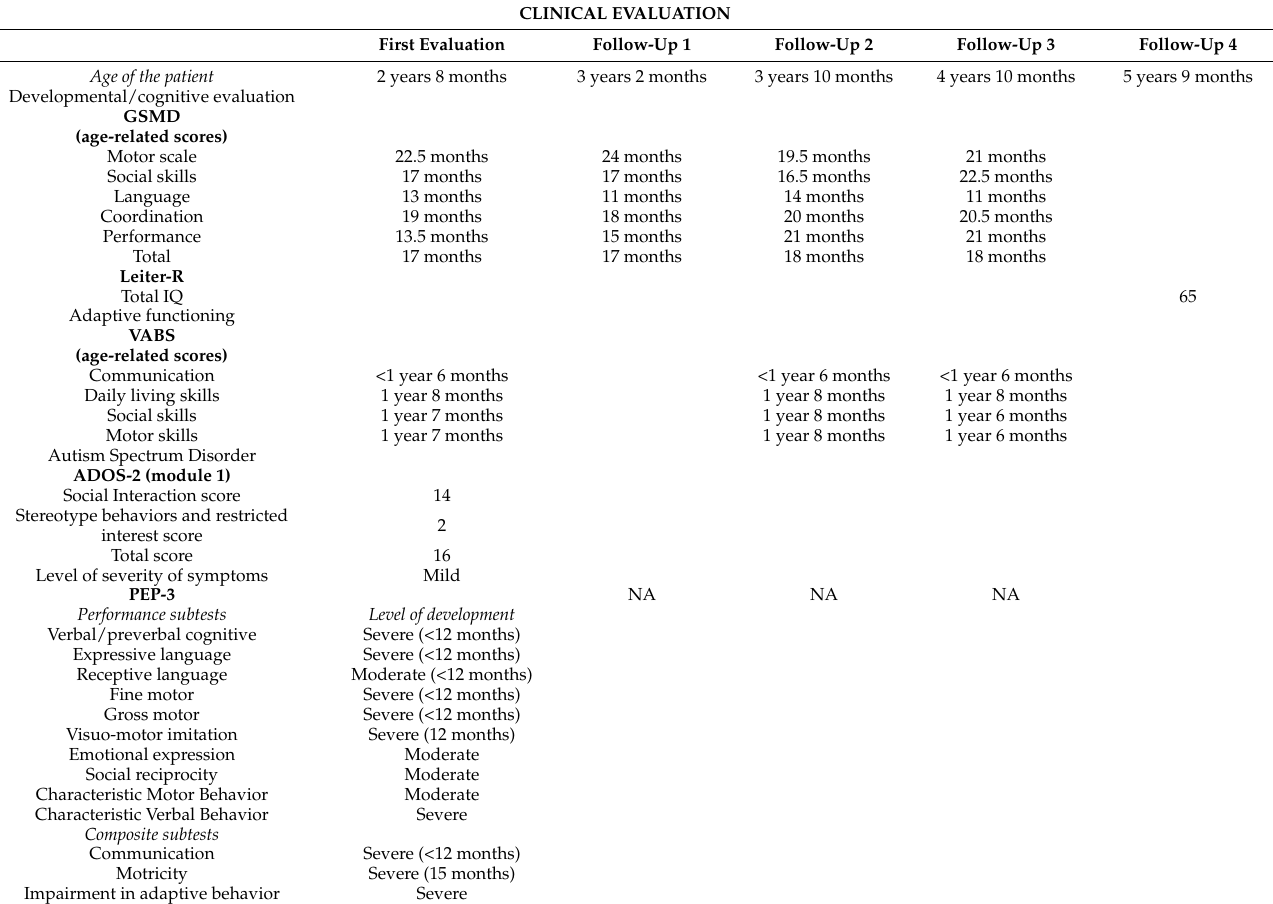
Table 1. Clinical evaluation of the patient. CLINICAL